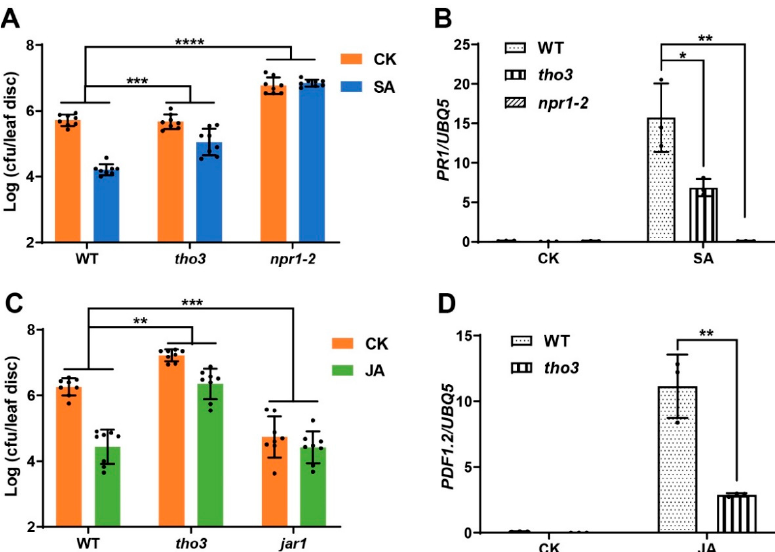
Figure 5. The phenotypes of SA and JA induced defenses in the mutant of THO3 , encoding another subunit of THO/TREX complex. ( A ) SA induced resistance to Psm ES4326 in WT, tho3, and npr1 mutants. Significant difference was detected by two-way ANOVA. Data are shown as mean ± SD (n = 8). ( B ) SA induced expression of PR1 in WT, tho3, and npr1 mutants. Significant difference was detected using Student’s t -test. Data are shown as mean ± SD ( n = 3). ( C ) JA induced resistance to Psm ES4326 in WT, tho3, and jar1 mutants. Significant difference was detected by two-way ANOVA. Data are shown as mean ± SD ( n = 8). ( D ) JA induced expression of PDF1.2 in WT and tho3 mutants. Significant difference was detected using Student’s t -test. Data are shown as mean ± SD ( n = 3). All these experiments were conducted as previous described and repeated three times with similar results. * p < 0.05; ** p < 0.01; *** p < 0.001; **** p < 0.0001.